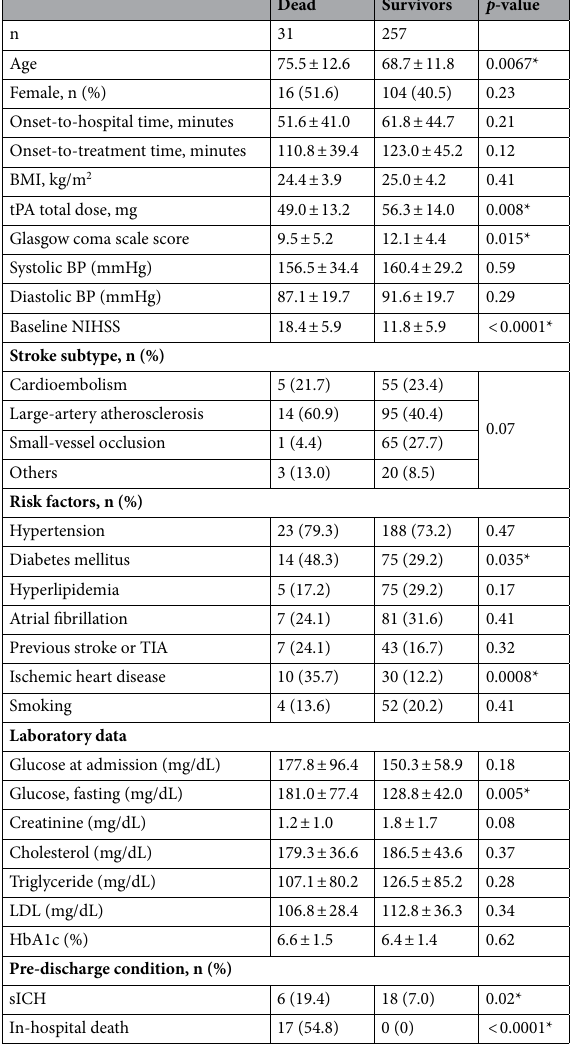
continuous variables, and Fisher’s exact test was used for categorical variables. BMI, body mass index. BP, blood pressure. HbA1c, hemoglobin A1c. sICH, symptomatic intracranial hemorrhage. LDL, low-density lipoprotein. NIHSS, National Institutes of Health Stroke Scale. mRS, modified Rankin Scale. TIA, transient ischemic attack. tPA, tissue plasminogen activator. * p- value <